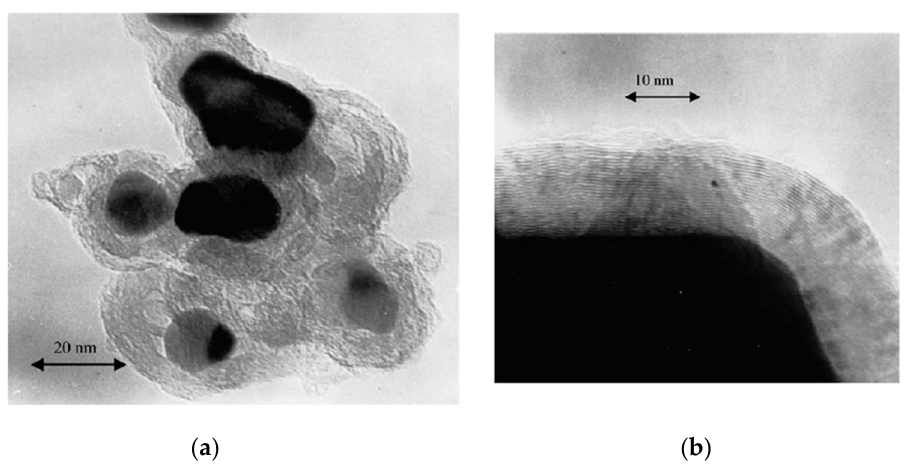
Figure 10. ( a ) TEM image of the encapsulated molybdenum carbide, Mo 2 C, particles formed during annealing of a HEBM molybdenum–amorphous carbon 1.5Mo-C mixture. ( b ) HREM image of the surface of molybdenum carbide, Mo 2 C, particles encapsulated by polyaromatic carbon formed during annealing of the HEBM 1.5Mo-C mixture. Reprinted from [41], Copyright (2004), with permission from Elsevier.